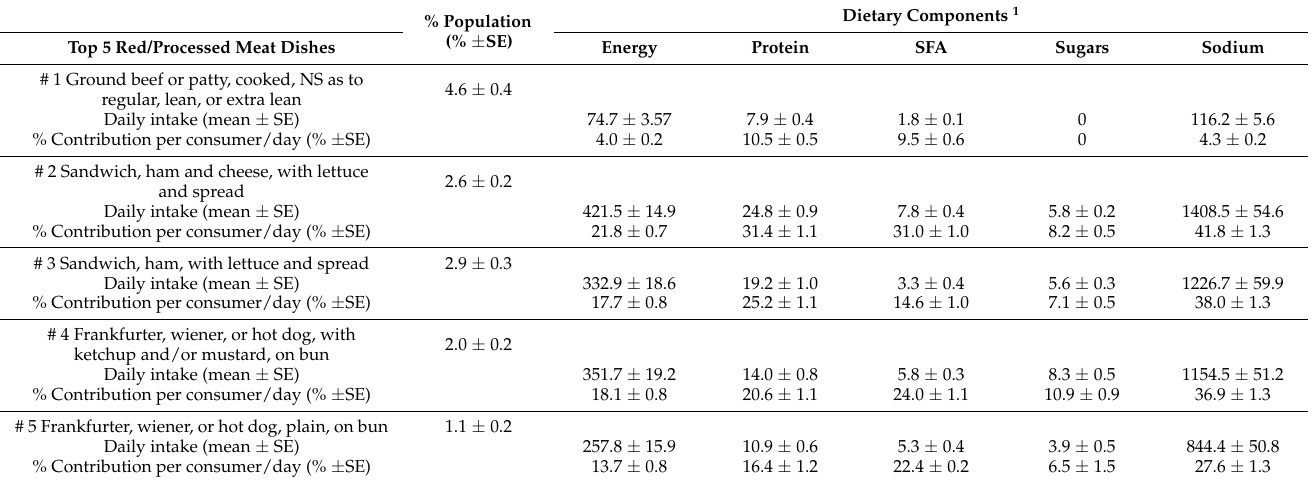
Table 4. The mean and percentage contribution of the top five reported red/processed meat dishes to nutrients-to-limit, energy, and protein intake of Canadians aged ≥ 1 year in Canada, 2015 Canadian Community Health Survey.